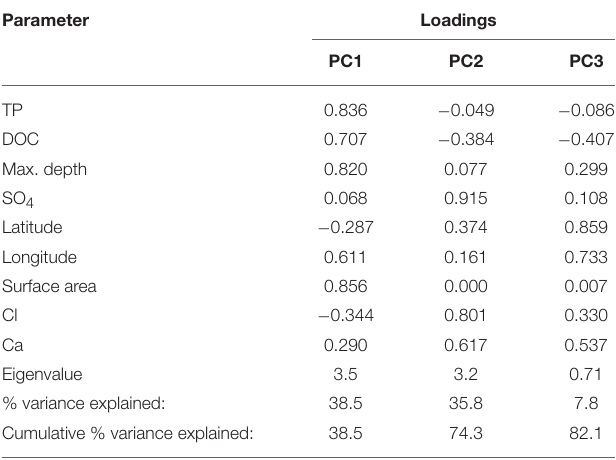
TABLE 6 | Rotated component matrix * showing the loading strength of the physical and chemical variables common across all salmonid lakes in each Principal Component (PC) resulting from the PCA.